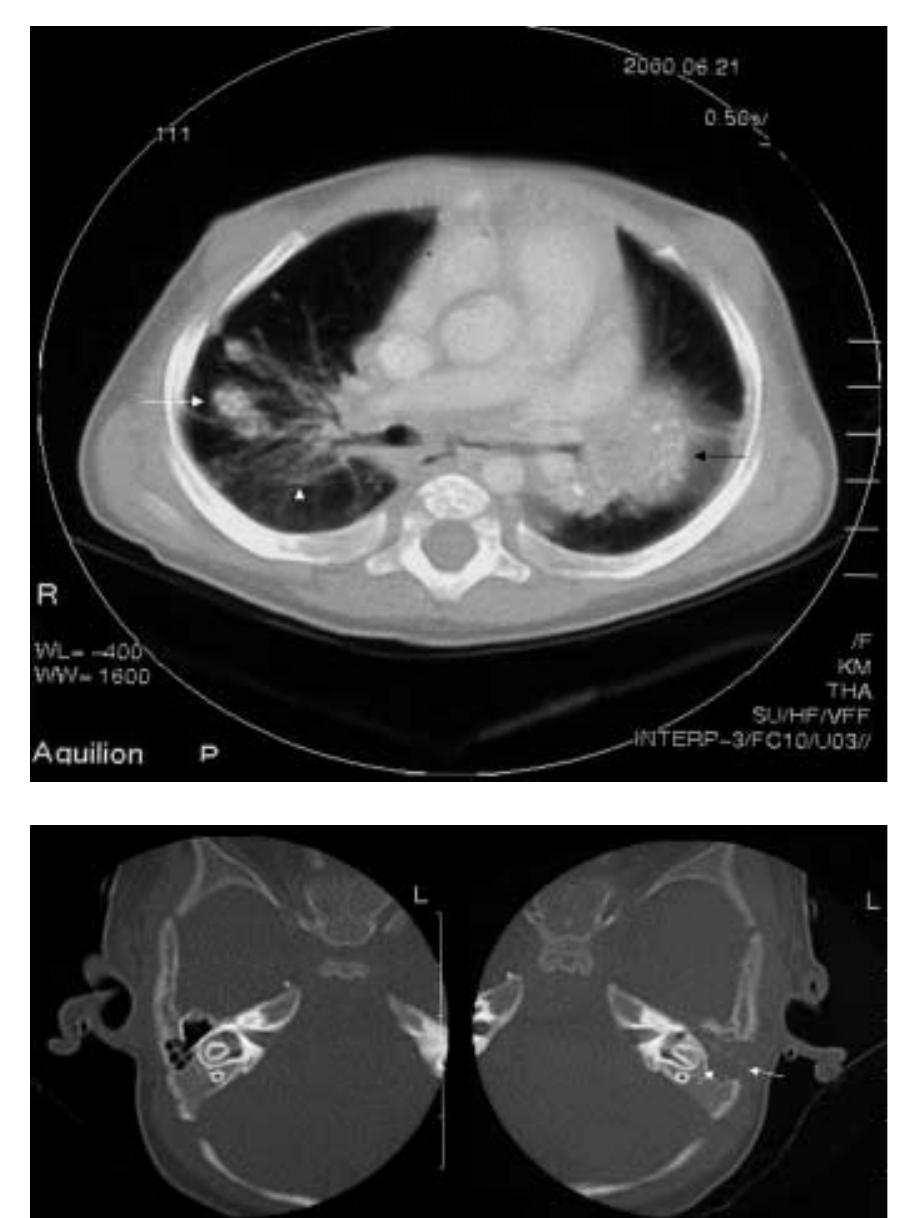
Computerised to- mography of the lung revealing calcifica- tions (white arrow), streaky infiltrates (white arrowhead) and consolidation (black arrow).